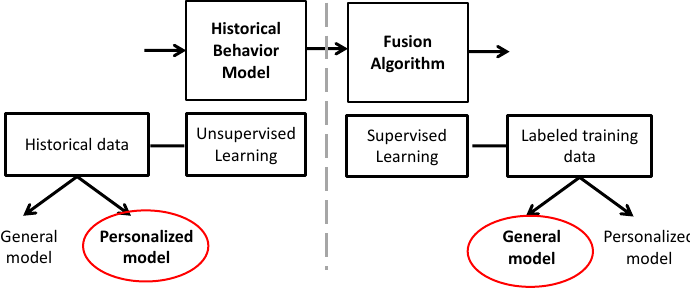
Figure 2. Diagram of unsupervised and supervised learning algorithms, with general versus personalized model